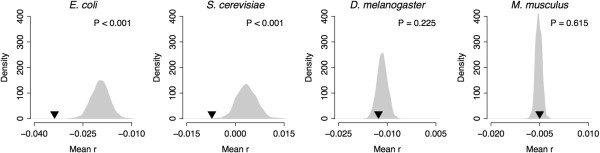
Test for association between weighted entropy and structural sensitivity. The black triangles indicate the mean Pearson correlation coefficient between these two quantities over all genes. The light grey areas show the sampling distribution of the same quantity under the null hypothesis of no association.